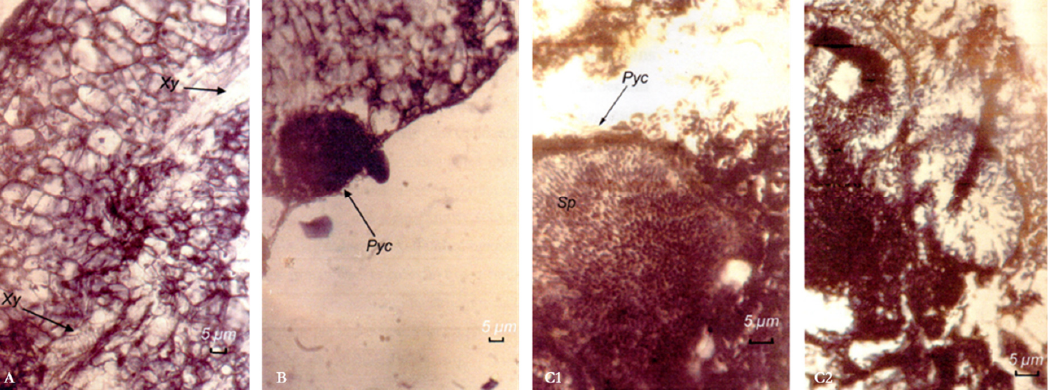
Figure 4. Microscopic observations of callus tissues from different genotypes inoculated with Ascochyta rabiei The tissues were obtained after 4 weeks of culture on MS media and 14 days after inoculation with the pathogen, which had been grown on a chickpea medium. (A) Histological section in a callus of the FLIP84-92 C genotype. Parenchymal cells with small nuclei; persistence of xylem conducting vessels. Absence of pathogen fruiting bodies in tissues. (B) Histological section in a callus induced from leaflets of the ILC 32-97 genotype. Presence of pycnidia in neoformed tissues. (C) Histological section in a callus of the ILC 263 genotype, characterized by the abundance of fruiting bodies of Ascochyta rabiei : 1) Detail of a pycnidia showing the large number of pycnidiospores in the tissues; 2) High number of spores of Ascochyta rabiei , which caused cell